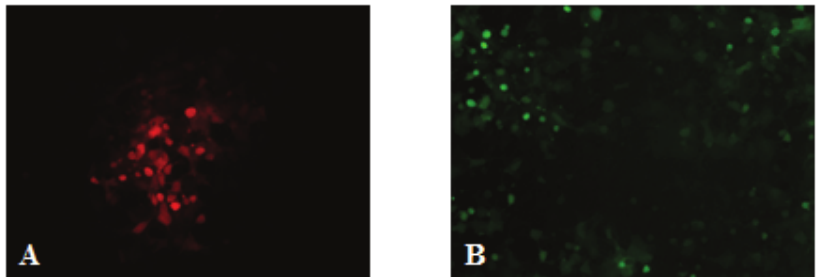
Figure 3. Fluorescence of Red or Green infected-cell foci on same field. At passage five, EPC cells were infected with rVHSV- Δ N-Red + rVHSV- Δ P-Green (m.o.i = 0.0001). Three days later, the same field of infected cells was examined for Red and Green fluorescence. Some of the infected cell foci appeared exclusively Red ( A ) or Green ( B ). A counting, mean of two independent experiments, of the monochromatic infected cell foci indicated an estimate of 9.6% of the total foci.